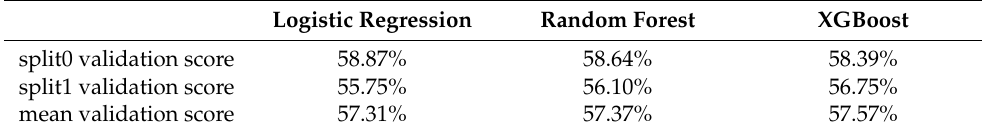
Table 4. ROC AUC Score from Validation.